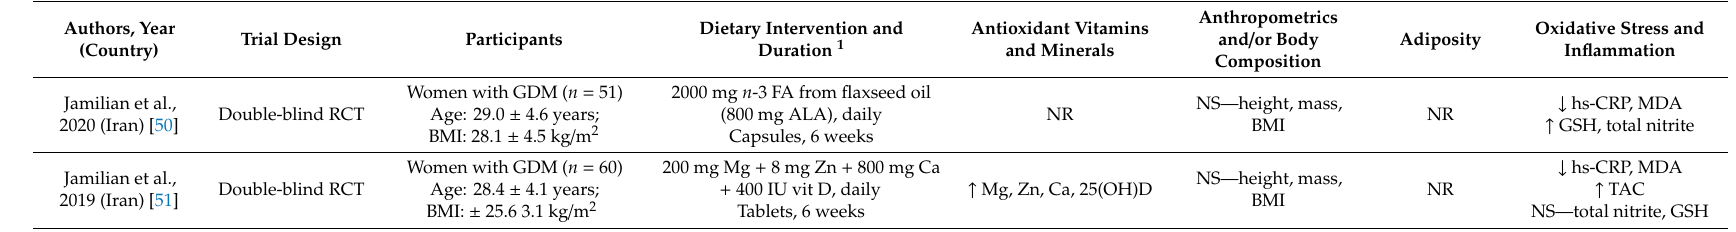
Table 2. Randomized controlled trials on the e ff ects of dietary bioactive compounds on maternal biomarkers of adiposity, antioxidant vitamin and mineral status, oxidative stress, and inflammation in gestational diabetes